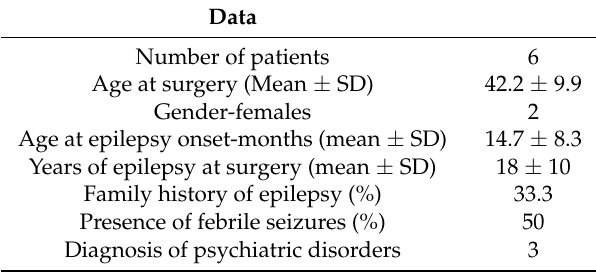
Table 4. Clinical and demographic data of patients with MTLE subjected to